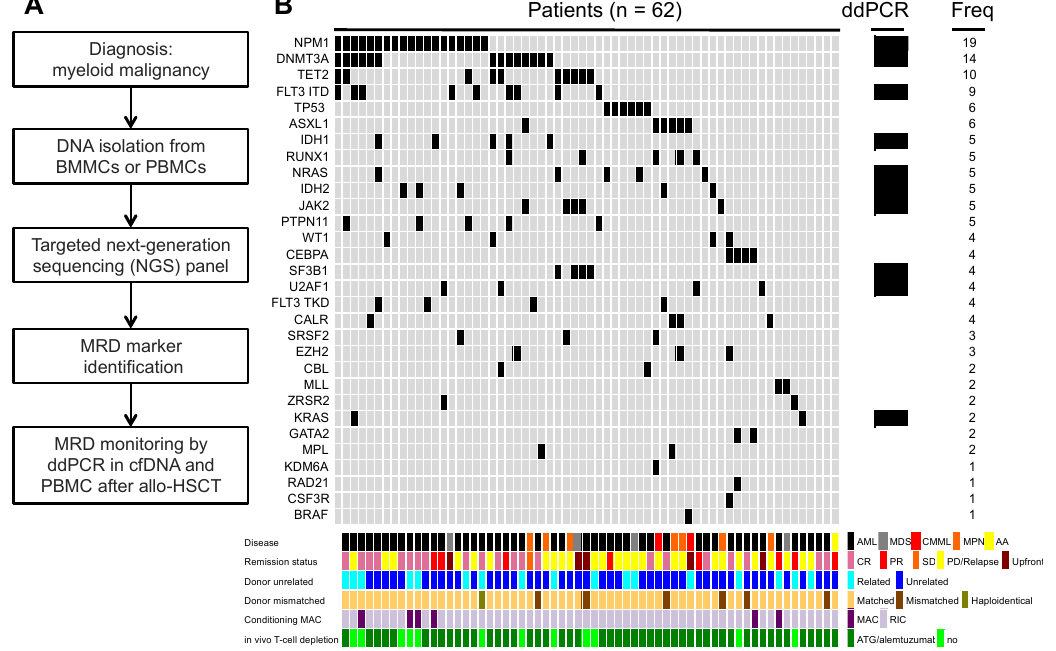
Figure 2. Identification of mutations for MRD monitoring in patients after allo-HSCT. ( A ) Workflow for identification of mutations for MRD monitoring in cfDNA in BMMCs from bone marrow aspirates or in PBMCs from peripheral blood. ( B ) Upper grid panel showing the identified mutations in single patients for MRD monitoring using droplet-digital PCR (ddPCR). Lower grid panel, disease and transplantation characteristics for each individual patient. ddPCR, droplet-digital PCR; cfDNA, circulating-free DNA; MRD, measurable residual disease; allo-HSCT, allogeneic hematopoietic stem cell transplantation; BMMCs, bone marrow mononuclear cells; PBMCs, peripheral blood mononuclear cells; NGS, next-generation sequencing; AML, acute myeloid leukemia; MDS,